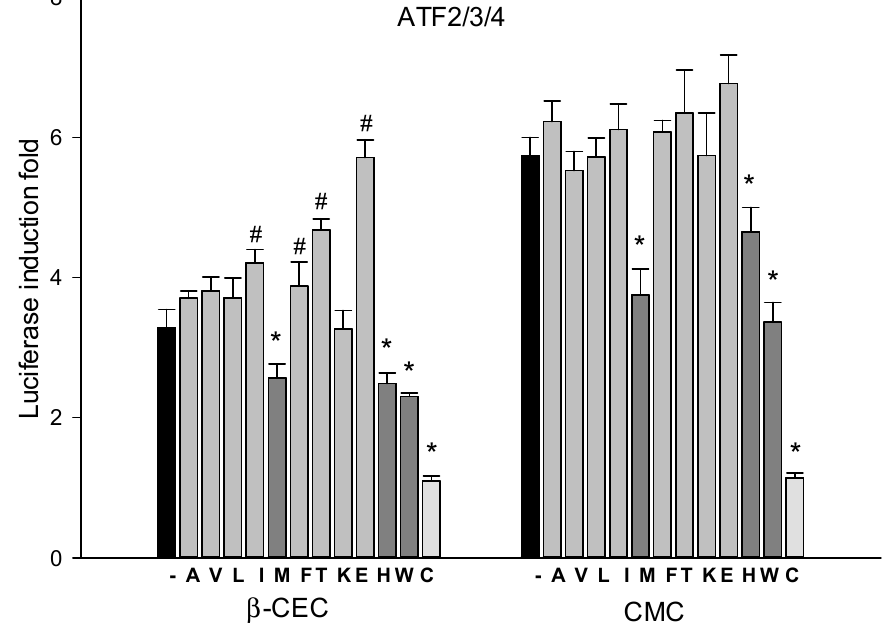
Figure 7. Transcriptional activation of the amino acid response pathway in NRK-52E cells treated with 4 mM β -CEC or CMC and co-treated with no or 4 mM amino acids for 18 h. The abbreviations are conventional one-letter abbreviations for amino acids, except for C standing for N -acetyl-L-cysteine. Responses significantly different from “not co-treated” in each group ( n = 3, p < 0.05) are marked with # (more than “not co-treated”) and * (less than “not co-treated”). See Supplementary Materials Table S16 for viabilities and extended data.